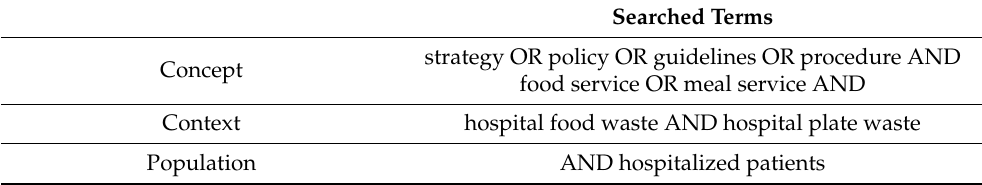
Table 1. Keywords used for this